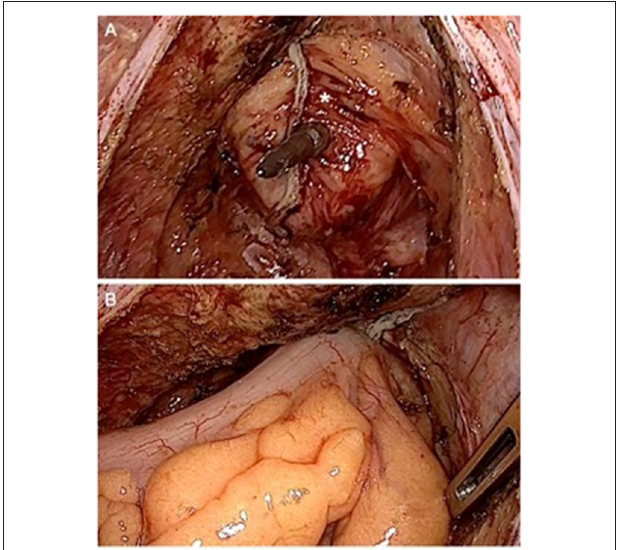
FIGURE 1 | Performing an end-to-end reconstruction after low rectal resection. (A) Rectal stump (*) still covered with fatty tissue to ensure perfusion with the spine of the stapler is piercing near the previous stapling line. (B) Compression after joining both ends to flatten fatty tissue before releasing the stapling